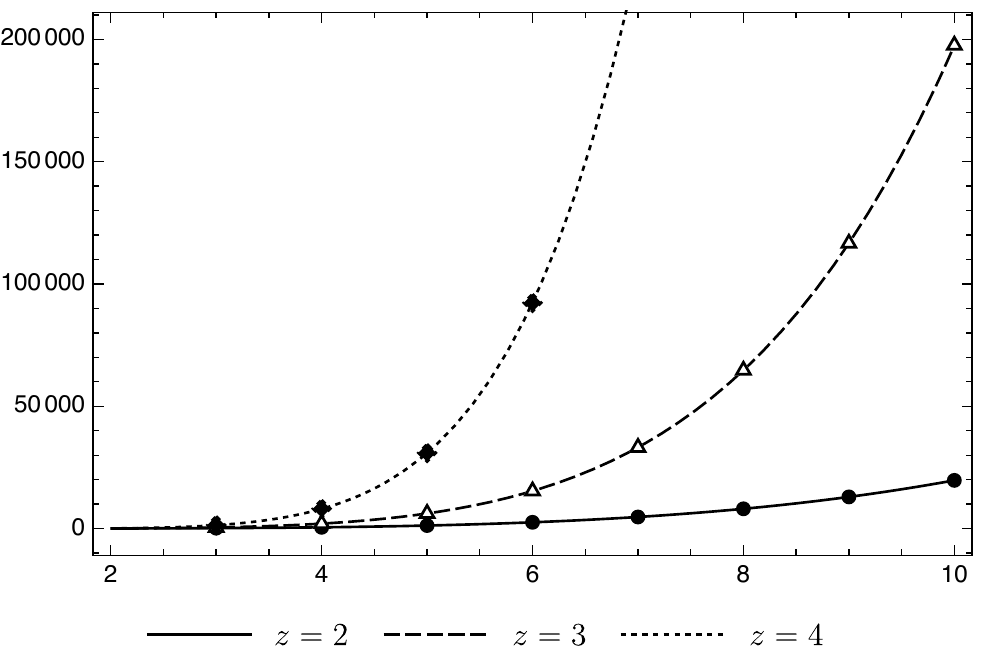
Figure 5 . The circle, square, and triangle points are numerical values generated from (5.9) for different horizon values, while solid, dashed, dotted curves are quartic, quintic and sextic polynomials, respectively. As demonstrated, the numerical values fit nicely to their corresponding polynomial